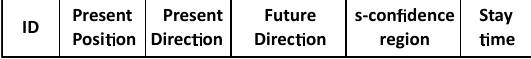
Figure 2. Control information packet